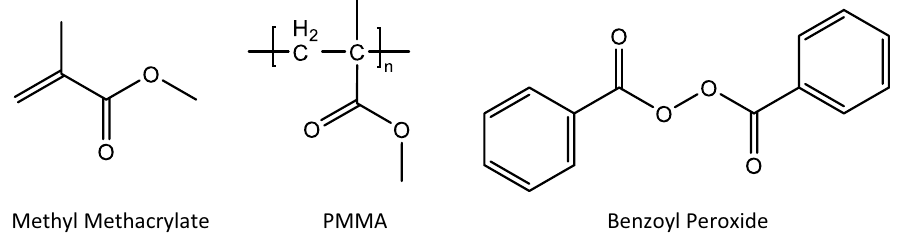
Figure 1. Molecular structures of main chemicals in bone